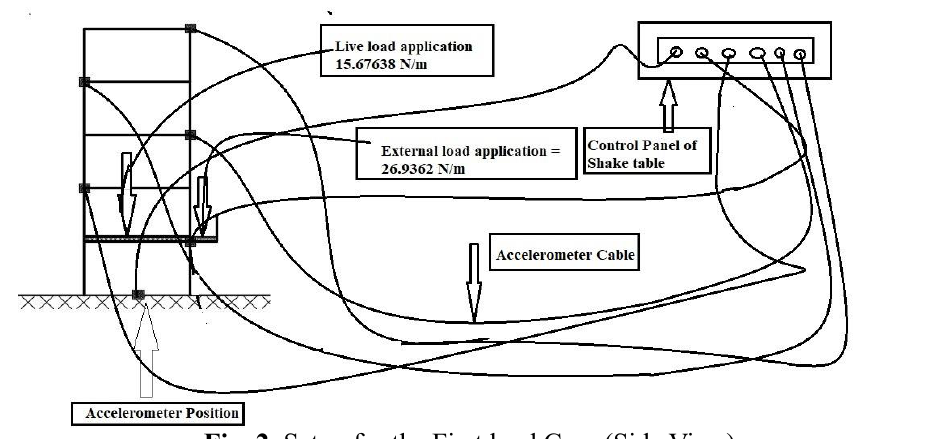
Fig. 2. Setup for the First load Case (Side